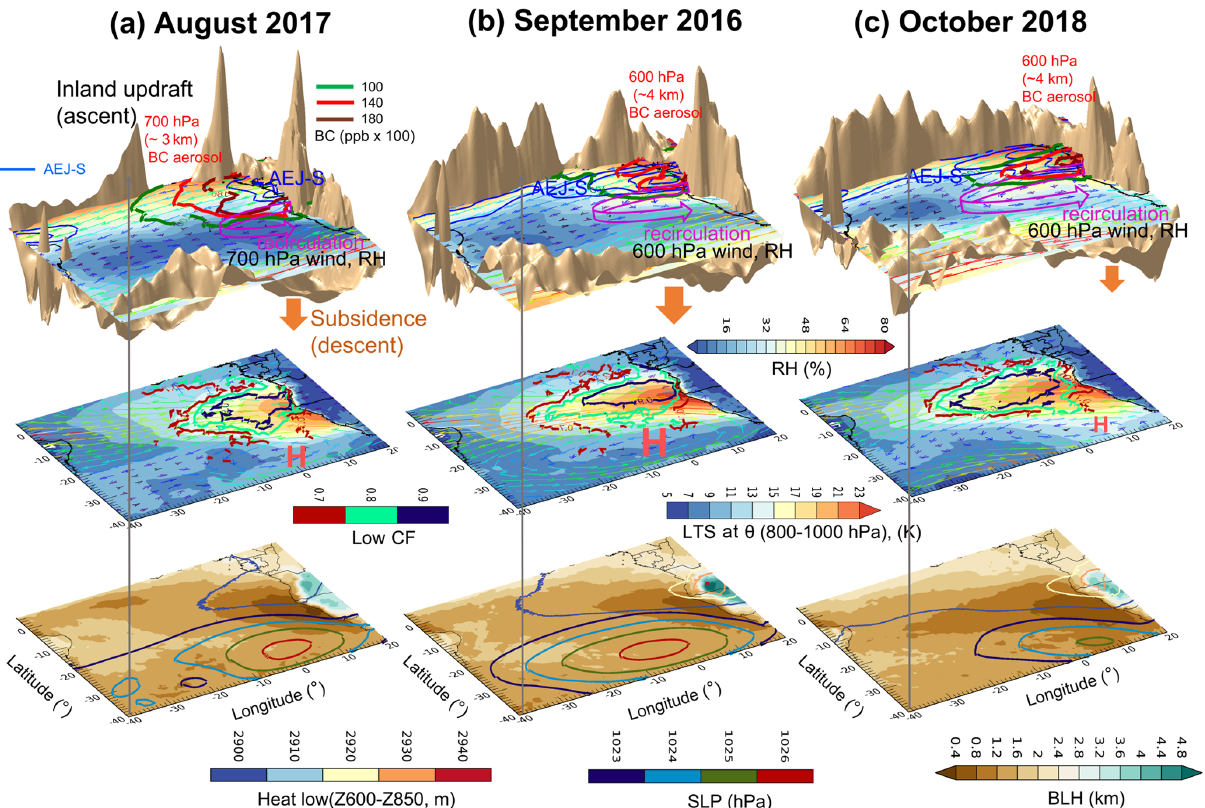
Figure 18. Visualization of (top panels) the map of 700hPa RH (shading; %), 700hPa horizontal wind (vector; ms − 1 ), and 700hPa BC aerosols (color lines; ppb × 100) for August 2017 and the same variables, except for 600hPa in September 2016 and October 2018. The 800hPa vertical velocity for all months (gold bumpy surface above the RH contour plane is an updraft and below the RH contour plane is subsidence; ω multiplied by − 1, i.e., − ω ; hPad − 1 ;). The middle panels show the map of LTS (shading; K) overlaid by 925hPa horizontal wind (vector; ms − 1 ) and low CF (color contours; 0.7%–0.9%). The bottom panels show the map of BLH (color shading; km) overlaid by thickness between 600 and 850hPa (color contours; m) and sea level pressure (SLP; color contours; hPa) during (a) August 2017, (b) September 2016, and (c) October 2018. The magenta arrow in the top panels represents the recirculating flow to the African continent. The red “H” in the middle panels refers to the anticyclones associated with the St. Helena